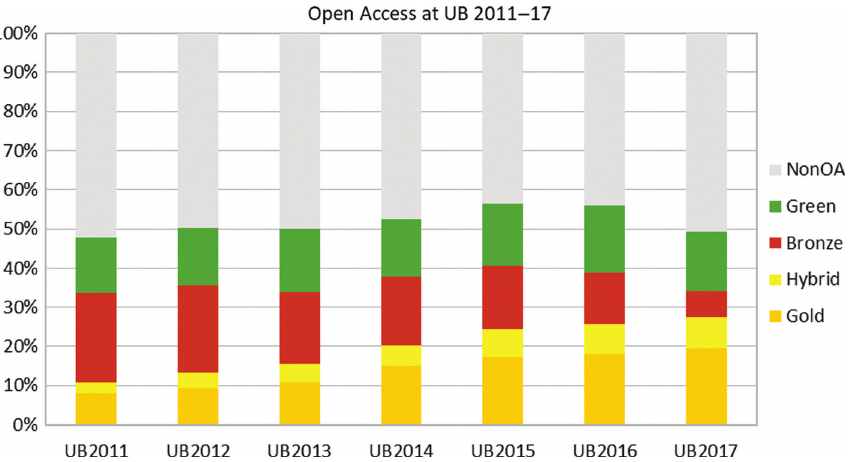
Fig. 2: Open Access situation at UPC 2011–2017. Analysis of the research publications from 2011 to 2017. Results obtained in June 2018.